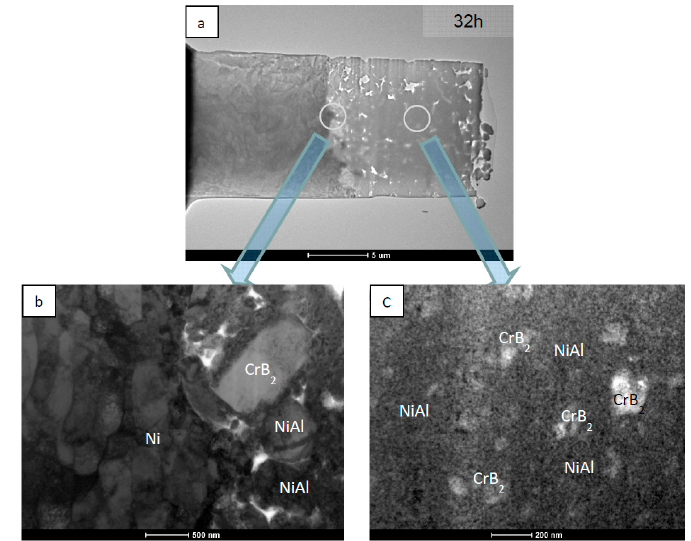
Figure 7. TEM images of NiAl + CrB 2 coating deposited on nickel substrate after 32 h of milling: ( a ) general overview, ( b ) substrate/coating interface, and ( c ) center of the coating.